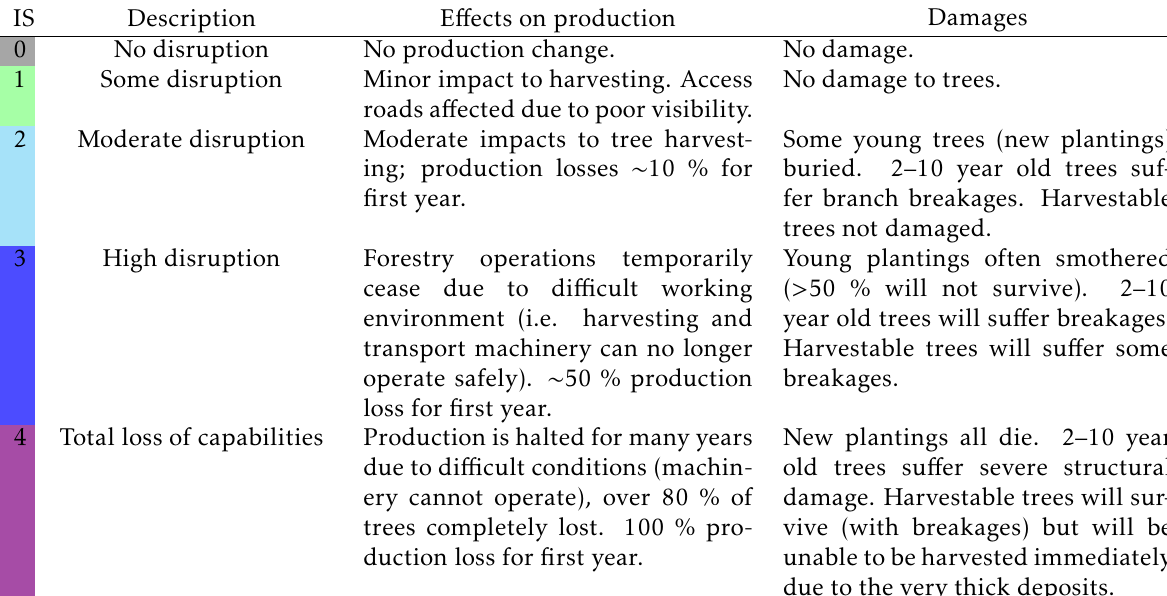
Table 6: Impact state (IS) scheme for forestry plantations. No photographs provided due to reliance on previous studies for forestry